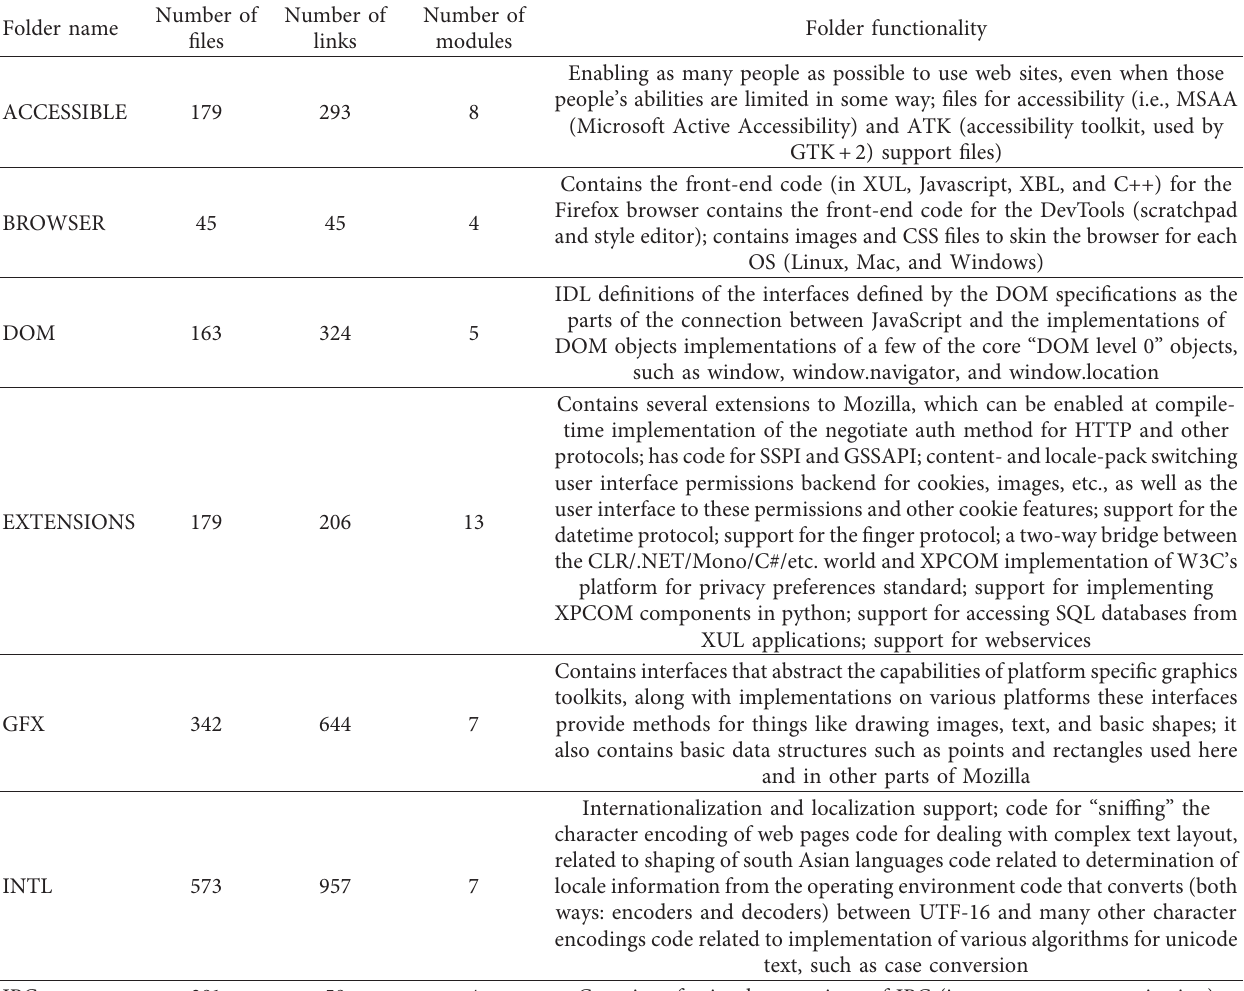
Table 2: Properties of selected folders.